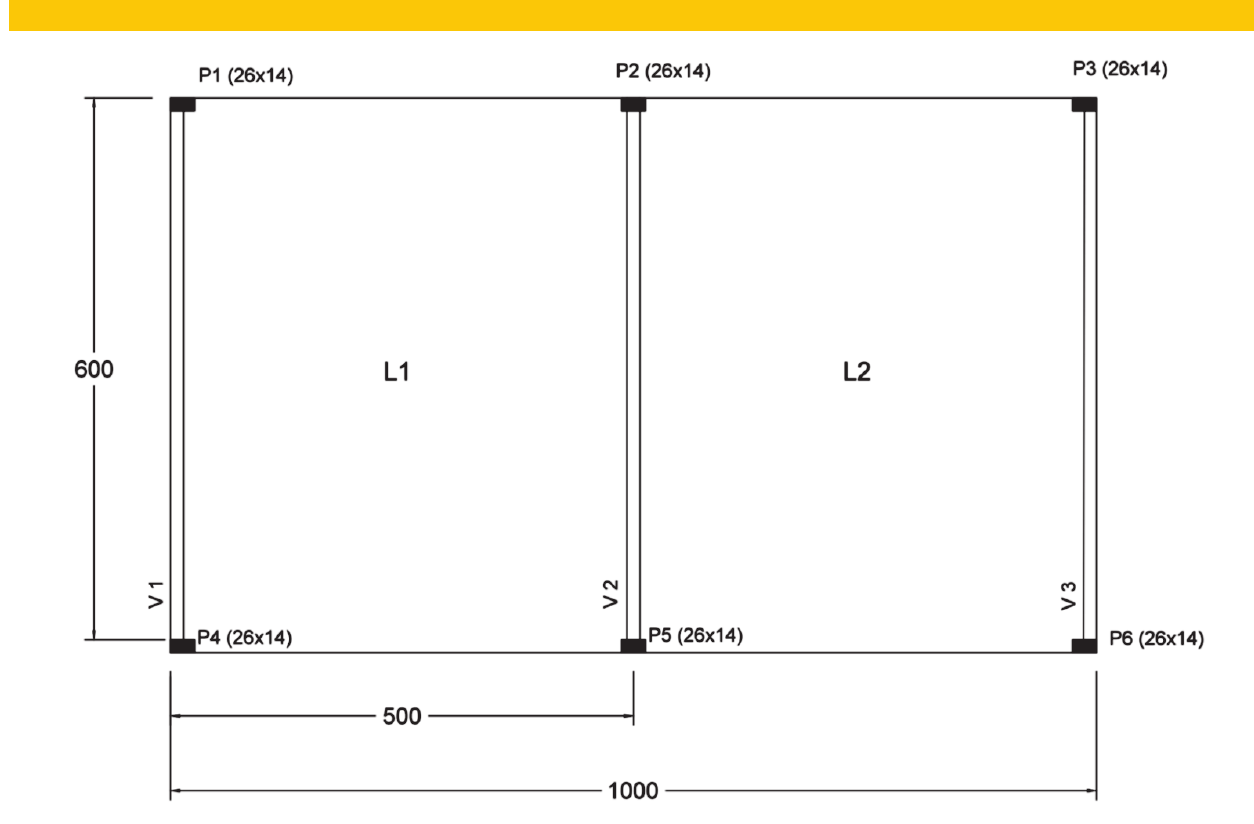
Figure 14 – Considered floor in the analysis: dimensions in